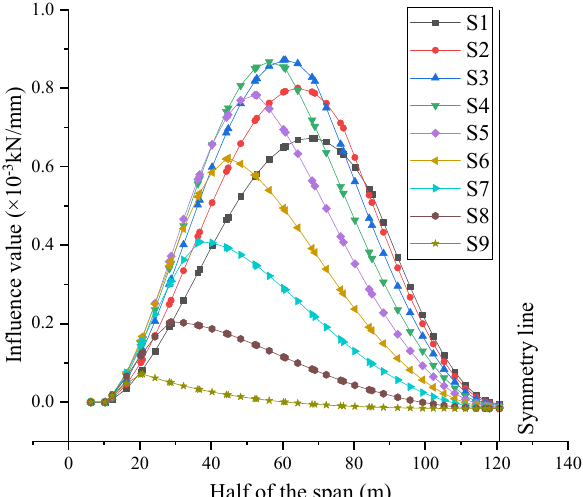
Figure 11. Influence of each cable on the vertical displacement of the main beam.